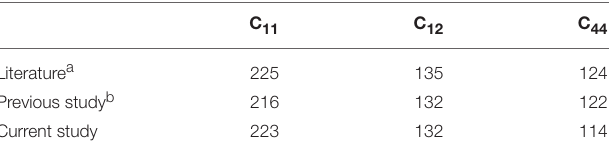
TABLE 1 | Comparison of reported estimates for single crystal elastic constants of the bcc-metal, Fe-3%-Si. All units are in GPa. C 11 C 12 C